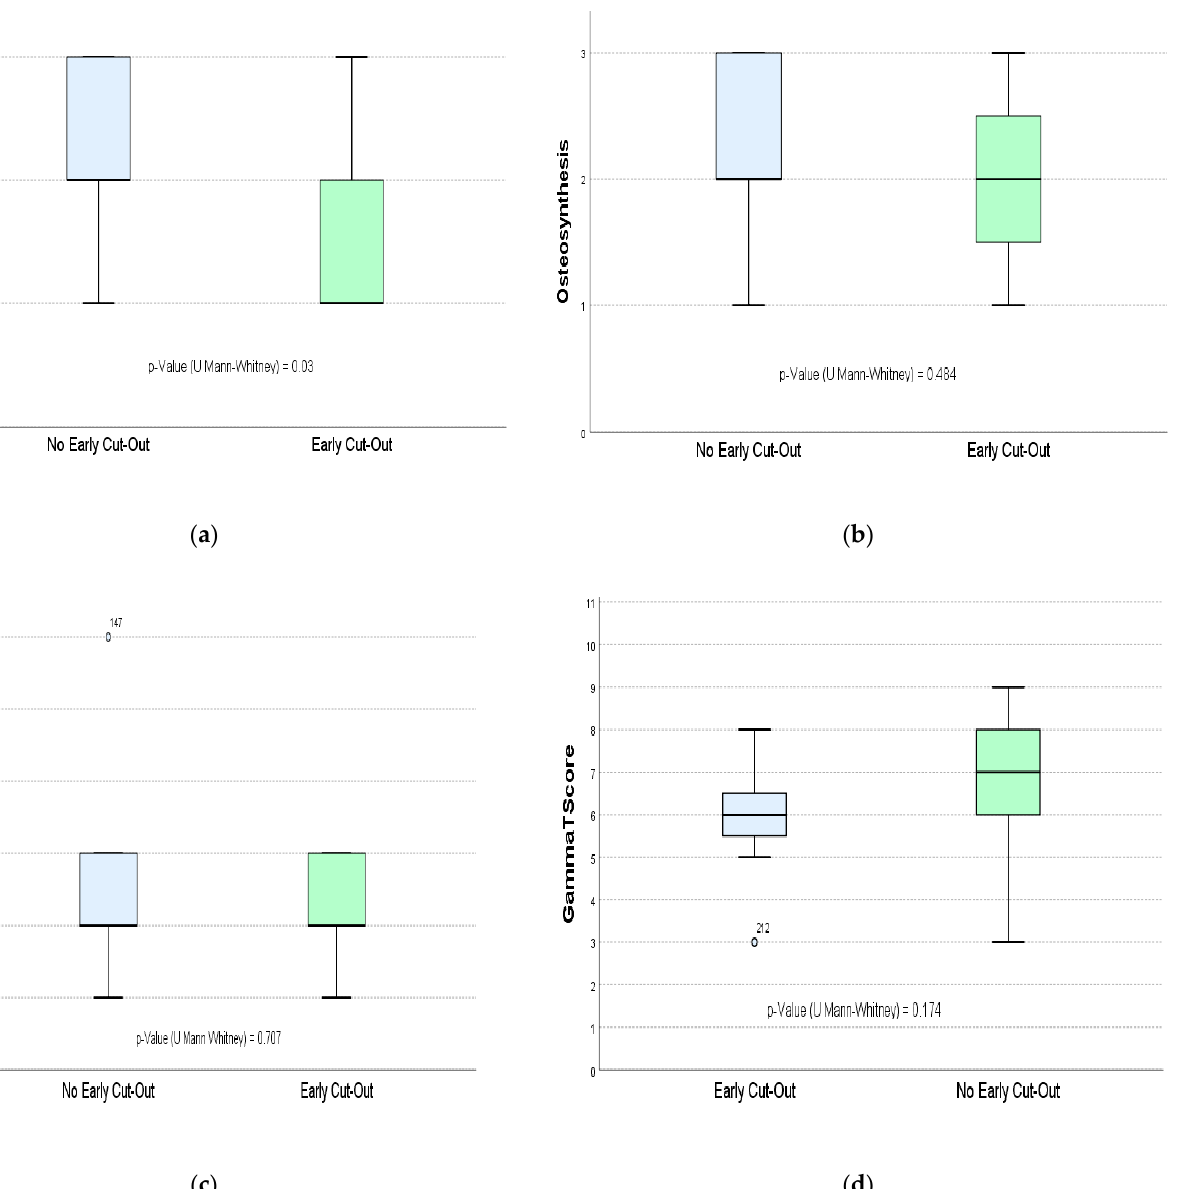
Figure 4. Representation of results of the GammaTScore tool, from top to bottom and from left to the right: ( a ) GammaTScore parameter—reduction; ( b ) GammaTScore parameter—osteosynthesis; ( c ) GammaTScore parameter—instability; ( d ) GammaTScore final rate. *, Statistically significative.